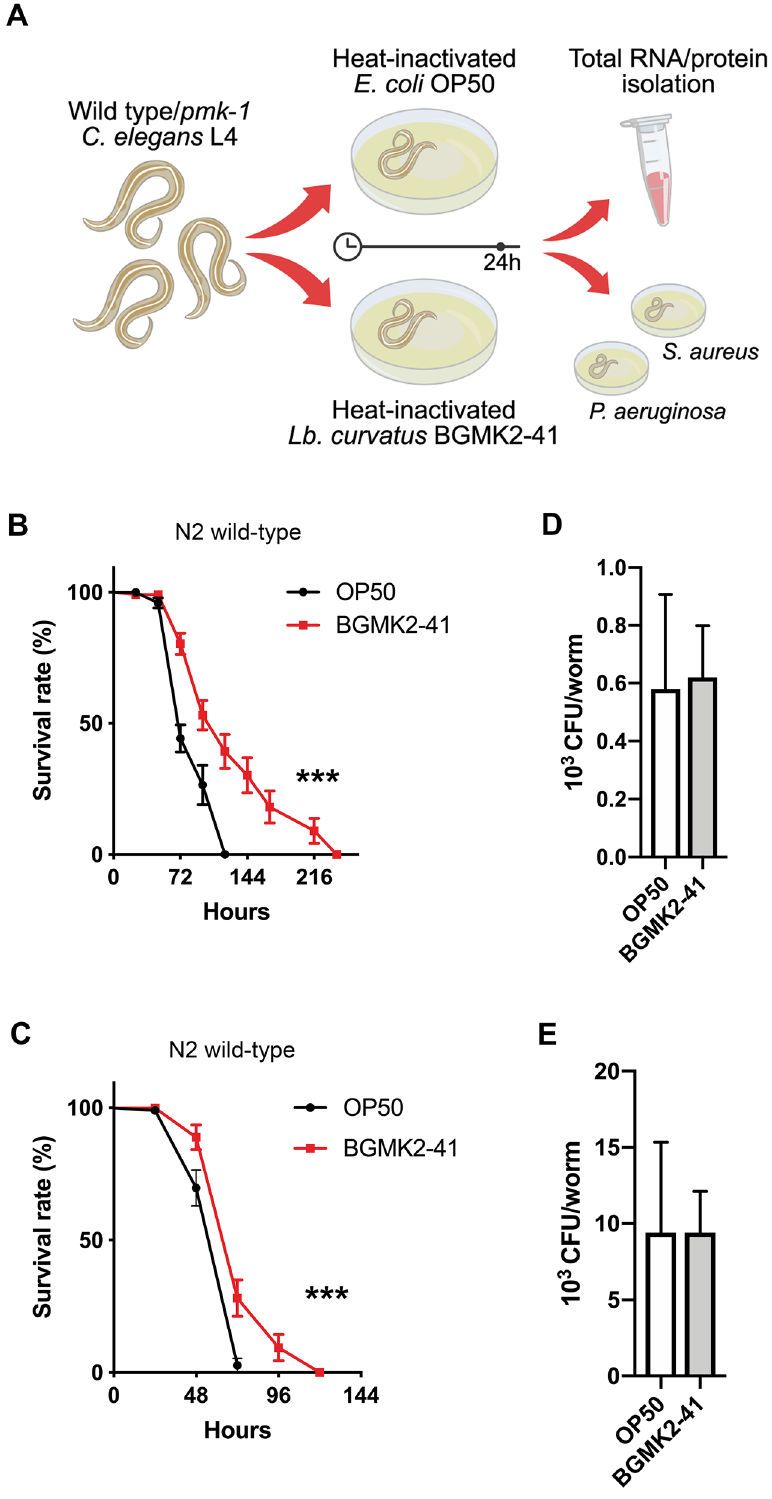
Figure 1. Heat-inactivated Lactobacillus curvatus BGMK2-41 prolongs the survival of C. elegans exposed to pathogenic bacteria. ( A ) An overview of experimental approach for evaluation of BGMK2-41 effects on infected worms’ lifespan and gene/protein. Survival curve of WT animals exposed to ( B ) S. aureus ATCC 25923 and ( C ) P. aeruginosa PA14 after overnight feeding of L4 stage worms with heat-inactivated control ( E. coli OP50) or BGMK2-41 bacteria (n = 25–30 worms per group, results are representative of 2 independent assays). CFUs level of ( D ) S. aureus ATCC 25923 and ( E ) P. aeruginosa PA14 present in the BGMK2-41 pre-treated worms after 1 day of exposure to pathogens (n = 10 worms per group, results are representative of 2 independent assays). All values are presented as mean ± SD and the student’s